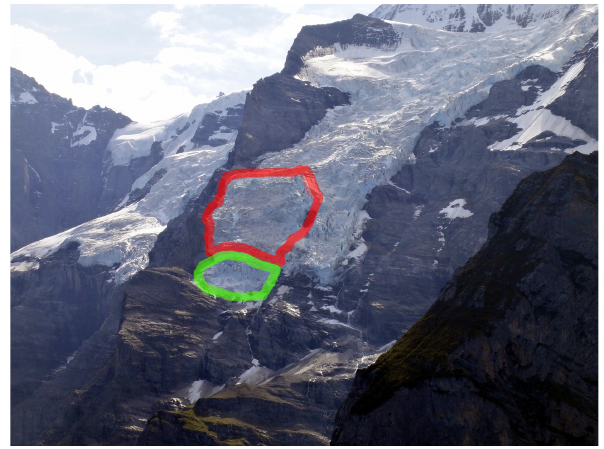
Fig. 19. Situation of Giesengletscher in 2011 from north. Green zone indicates the stable part of the tongue, in red the possible un- stable